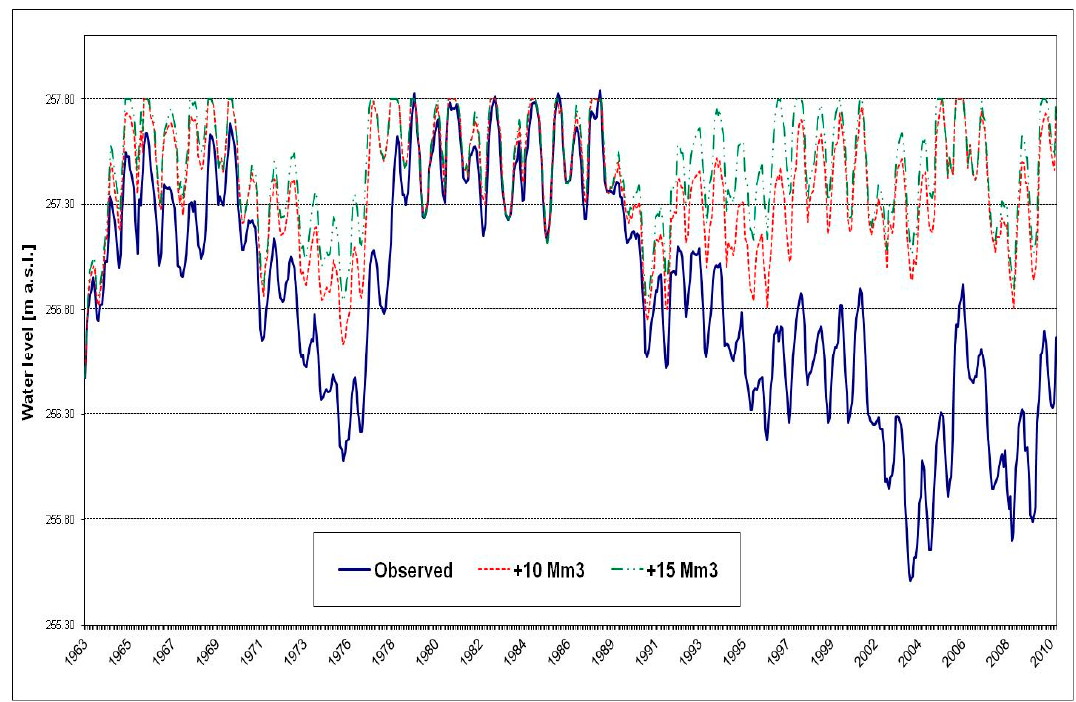
Figure 9. Estimated and observed Lake Trasimeno levels during the calibration phase (1963–1999) and the validation phase (2000–2010).